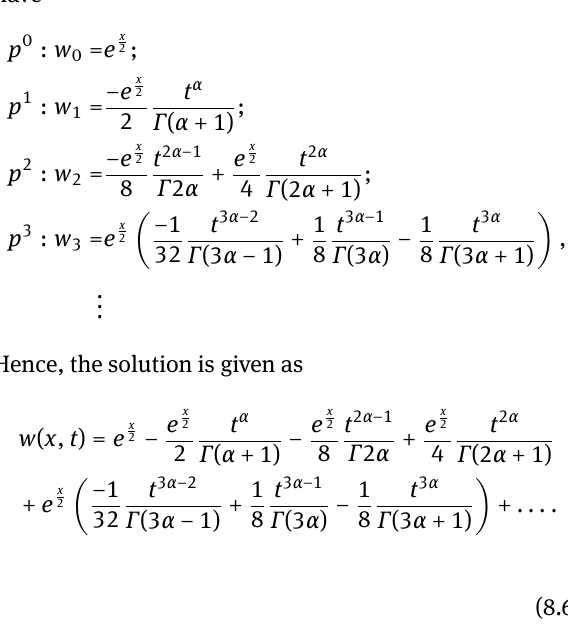
Fig. 4: Surface graph of w ( x , t ) of eq. (8.1), when α = 1 (exact solu- tion)